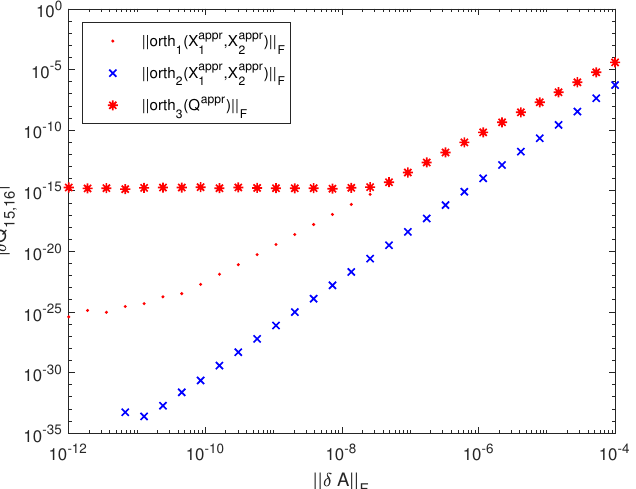
) (cid:107) (cid:107) orth ( X appr ) (cid:107) (cid:107) orth ( ˜ Q appr ) (cid:107) , X appr , X appr F , F , 2 3 2 2 1 1